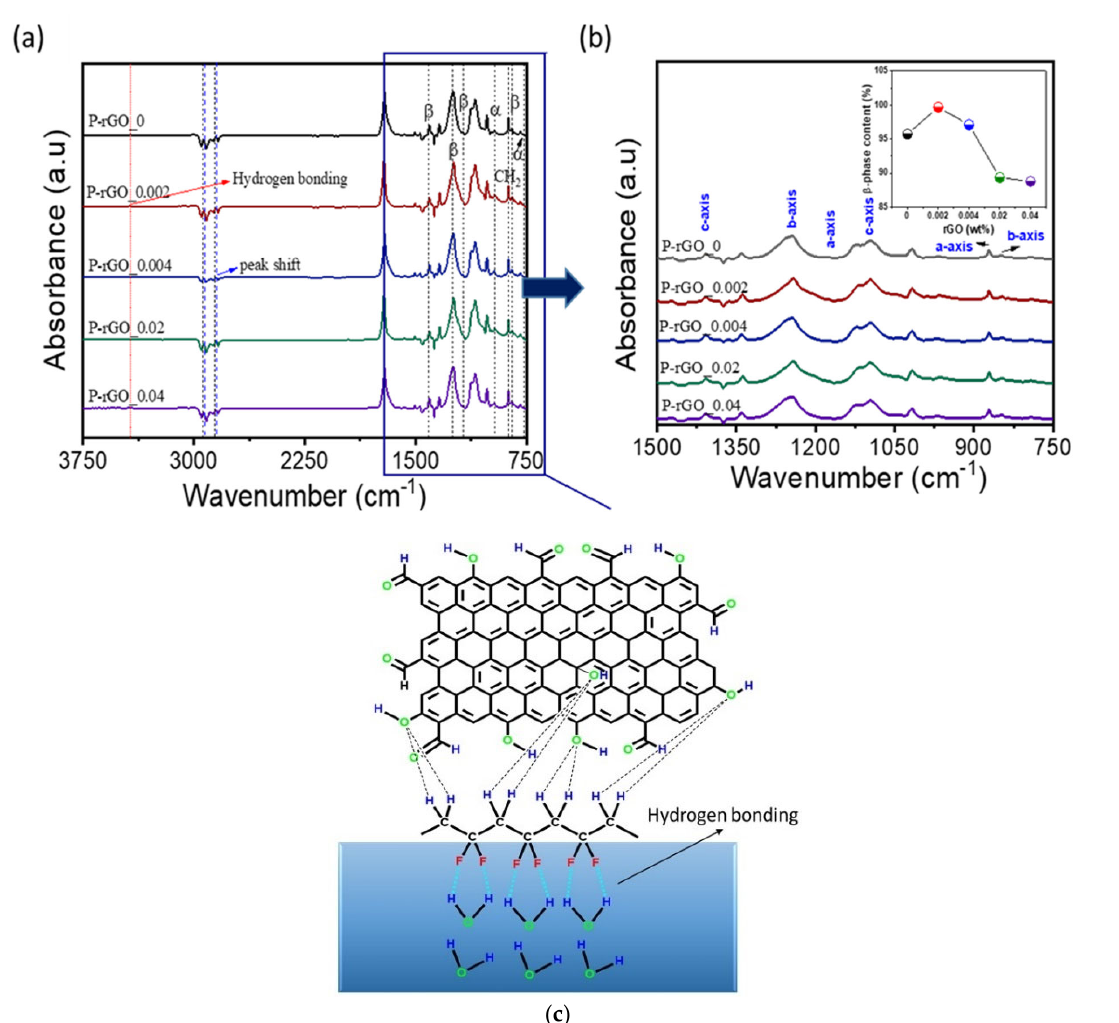
Figure 4. ( a ) FT ‐ IR spectra of five thin films; ( b ) detailed peaks in the range of 750–1500 cm − 1 in the FT ‐ IR spectra, and β‐ phase content (%) analysis; ( c ) illustration of hydrogen bonding among water molecules, polymer matrix, and rGO particles.